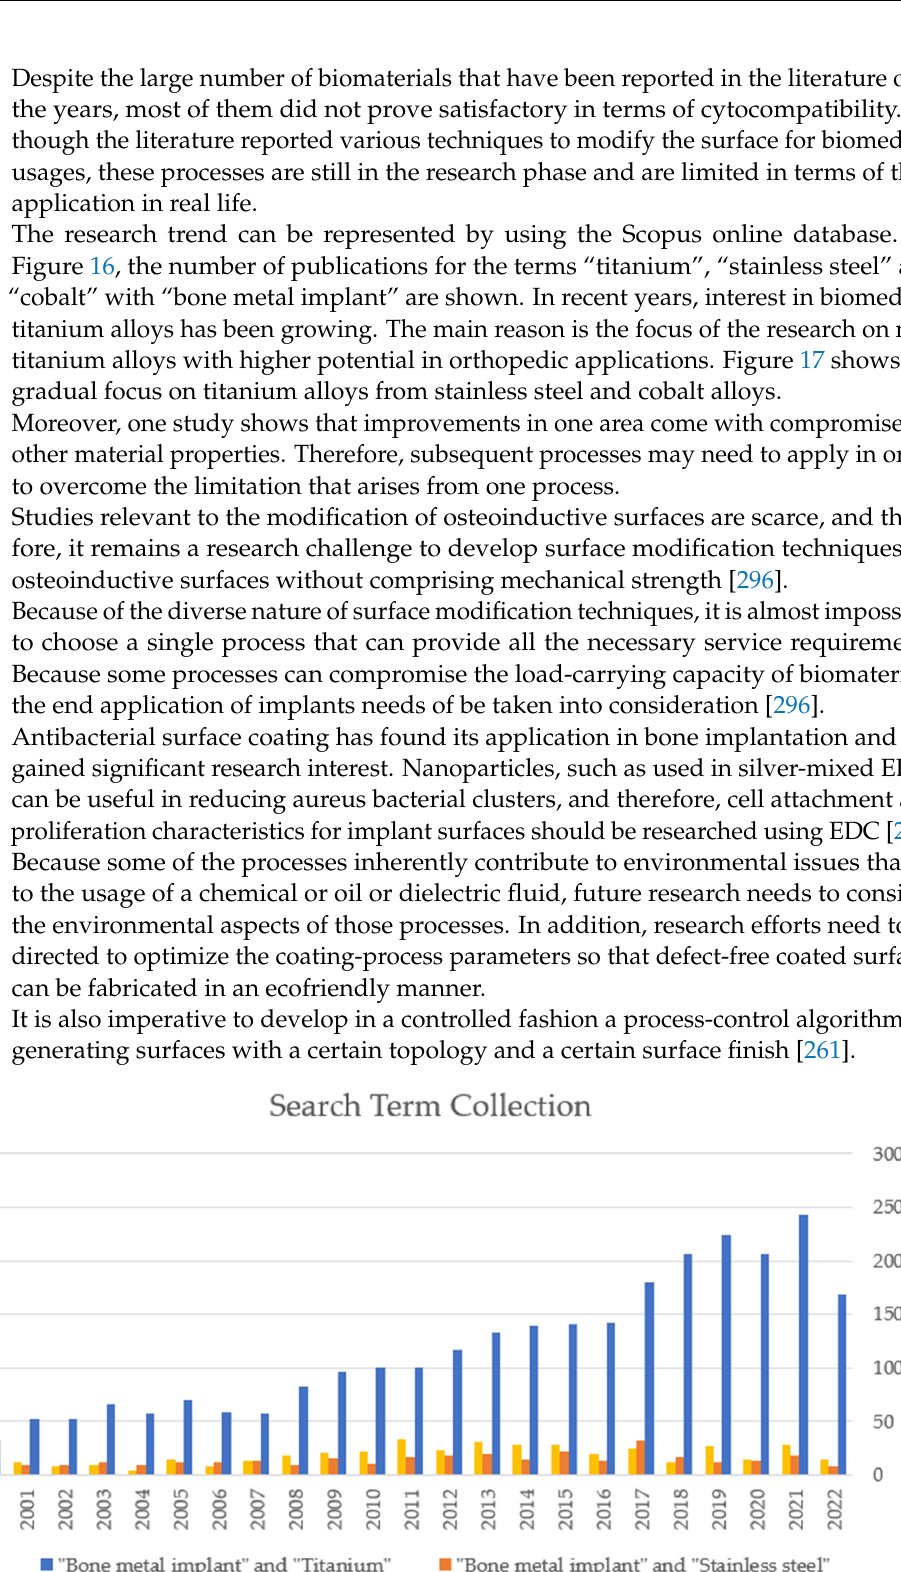
Figure 17. The share of the number of publications among three major metal classes in the Scopus online database. 6. Summary The application of metallic implants in biomedicine remains a challenging process in terms of biocompatibility. There are no ultimate criteria to estimate surface requirements, because each approach has advantages and disadvantages. For instance, the osteointegra- tion of implants is required to form excellent bonding between implant and bone. How- ever, these bonds will be broken when the implant is removed. Moreover, the studies on implant failures are limited owing to the nonregular shape of the bone and complex load- ings on implants when implanted. The main focus is on the mechanical properties on the longitudinal axis. The reasons for that are the vertical loads applied on the implants.